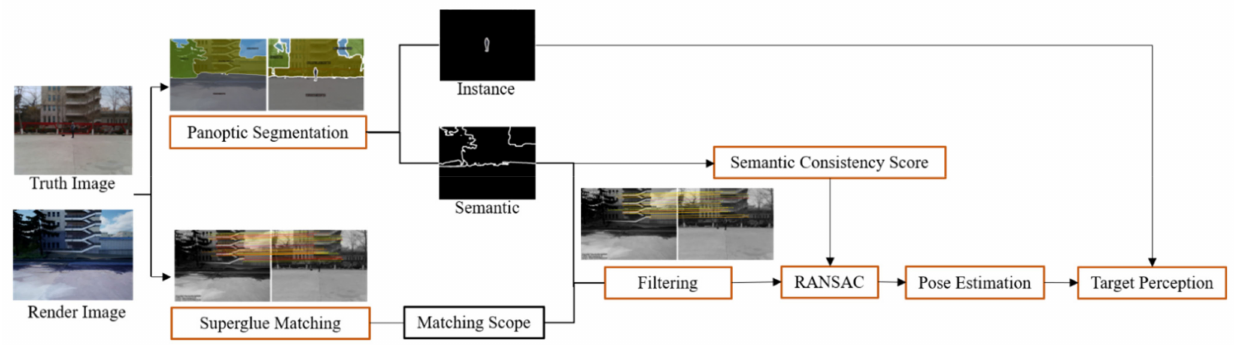
Figure 2. Overview of the proposed